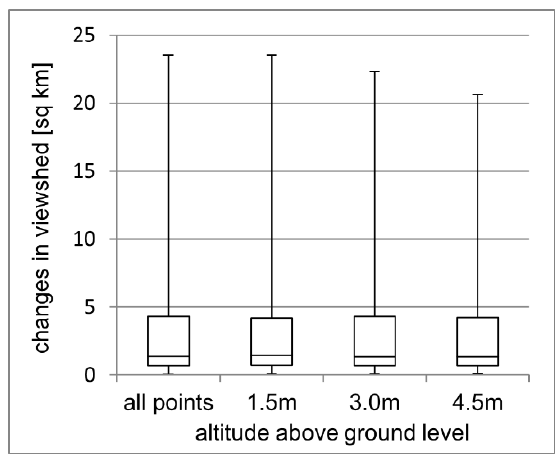
Figure 6. Distribution of amounts of maximal changes in viewshed in the period 1848 – 2015.